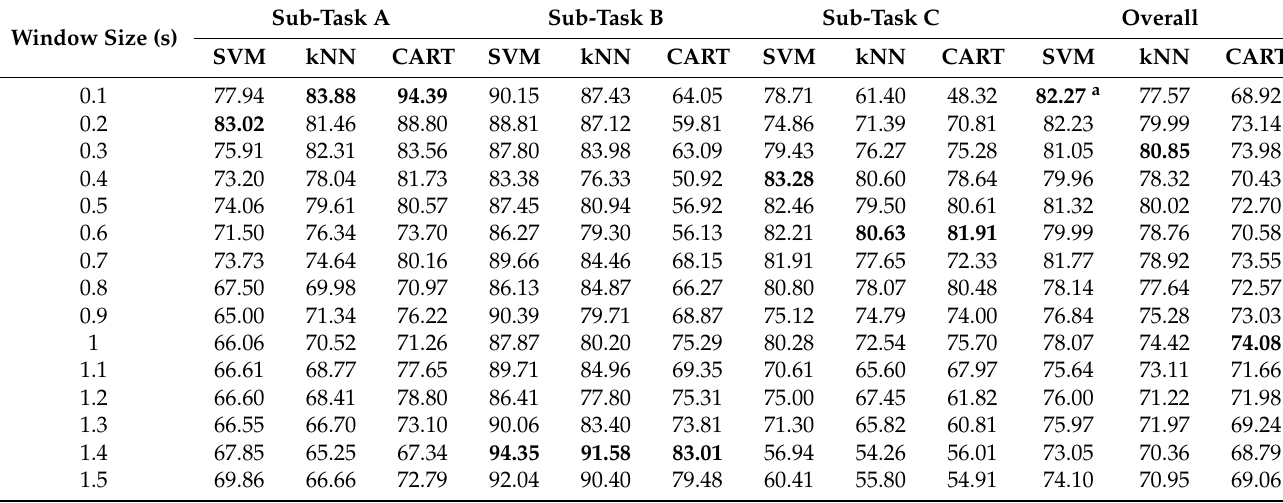
Table 5. The sensitivity of the sub-task segmentation using machine learning approaches (%) vs. different window sizes (s). Window Size (s)